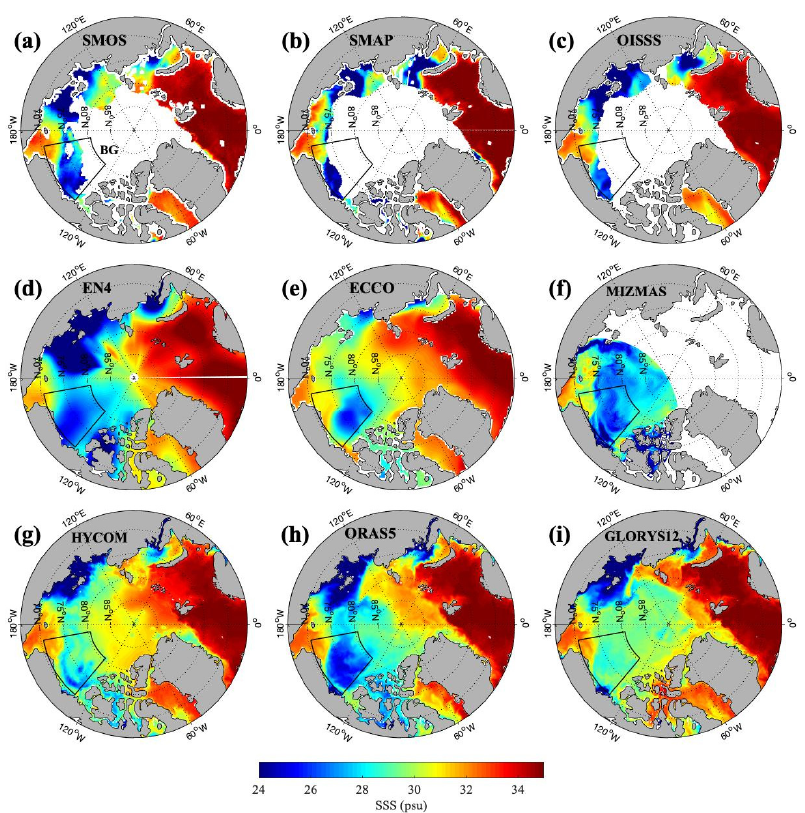
Figure 2. Arctic Ocean sea surface salinity (SSS) averaged over the month of September 2015 from satellites: ( a ) SMOS, ( b ) SMAP, ( c ) OISSS, objective analysis product: ( d ) EN4, and ocean model simulations: ( e ) ECCO, ( f ) MIZMAS, ( g ) HYCOM, ( h ) ORAS5, and ( i ) GLORYS12.